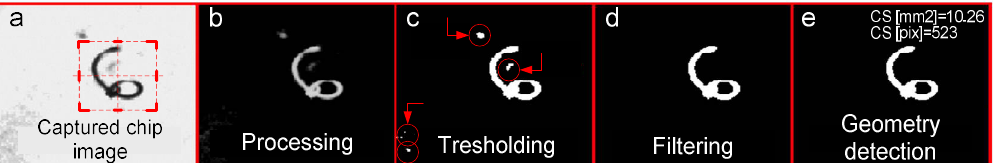
Figure 3. Results of image acquisition ( a ), processing ( b ), thresholding ( c ), filtering ( d ) and geometry detection ( e ) for the determination of chip surface size.